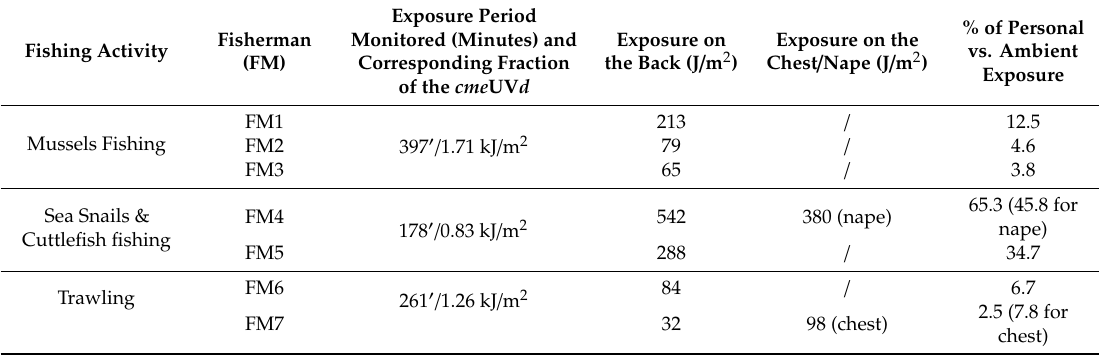
Table 2. Individual solar UV exposure measured for the seven fishermen on the first day of